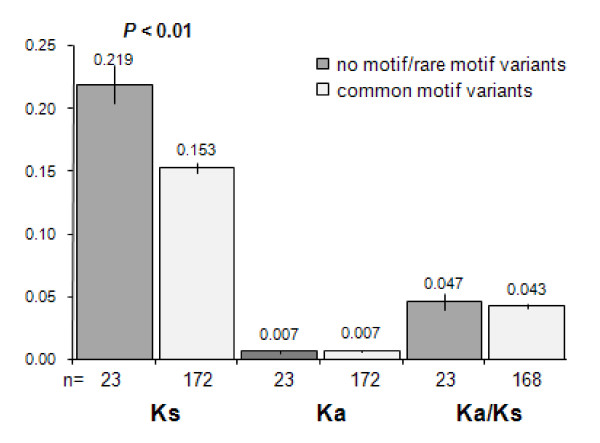
Average Ks, Ka and Ka/Ks values (and standard errors) estimated for pairs of duplicated ribosomal genes (as products of the most recent polyploidization event in P. tetraurelia). Average diversity values are examined between gene pairs where both copies contain the DUAYAWUW motif and gene pairs where at least one of the copies does not contain this motif.